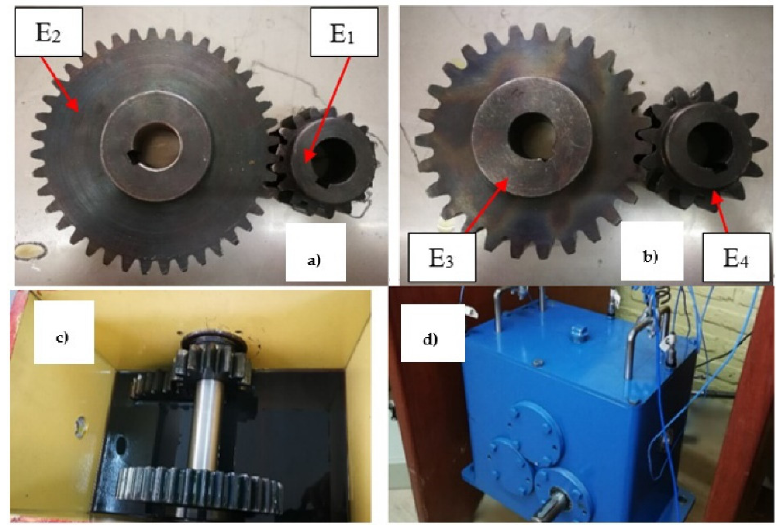
Figure 2. Experimental set up for gearbox’s measurements: ( a , b ) show the set of the spur gears, ( c ) denotes the gearbox’s top view, and ( d ) shows the gear box and mounted accelerometers. Figure 3 denotes the measurement set up for EMA for an induction motor and